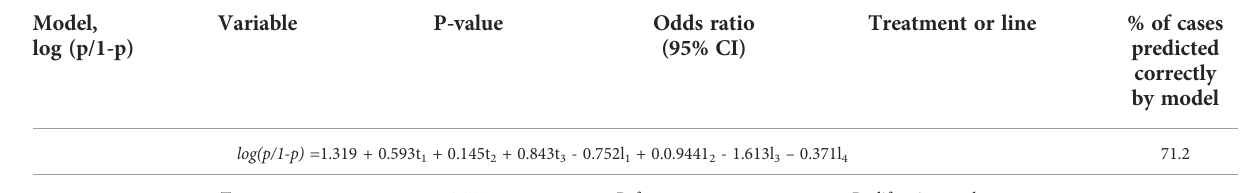
TABLE 4 Logistic regression model of greenhouse survival after 41 days in Trial